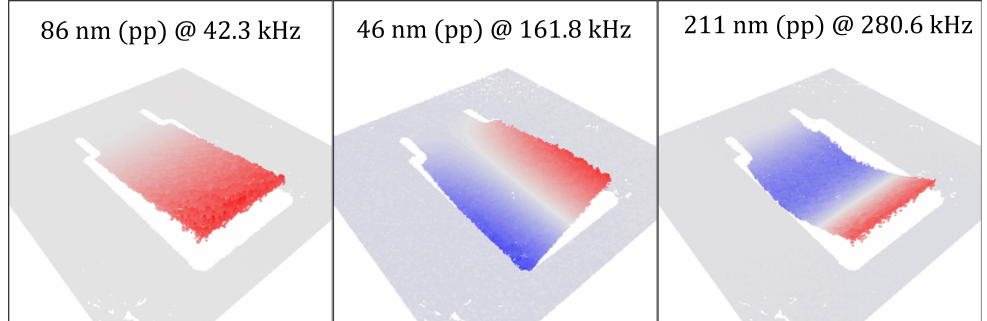
Figure 9. Representation of the bending ( left , b1 and right , b2) and torsional ( center , t1) modes recorded with the laser scanning vibrometer. Red and blue coloring represents the normalized deflection. The amplitudes shown correspond to the peak-to-peak values.